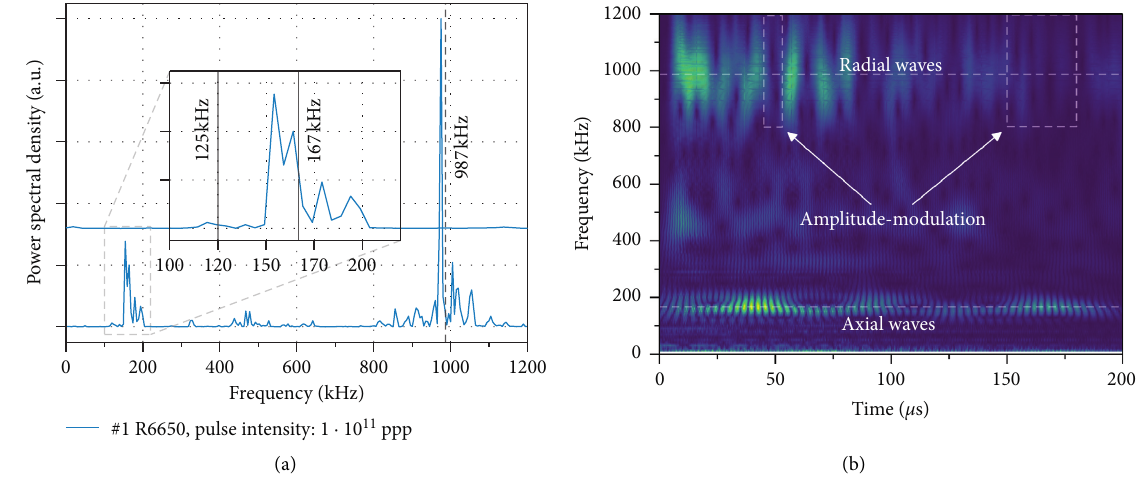
Figure 6: Frequency analysis of the radial surface velocity of target #1 R6650 after impact with 1 × 10 11 ppp within the first 200 μ s. The power density as a function of frequency clearly shows the multiple high frequency signals (around 1000kHz) responsible for the amplitude modulation (a). Continuous wavelet analysis of the absolute radial surface velocity. Color coding represents the values of the normalized absolute radial surface velocity